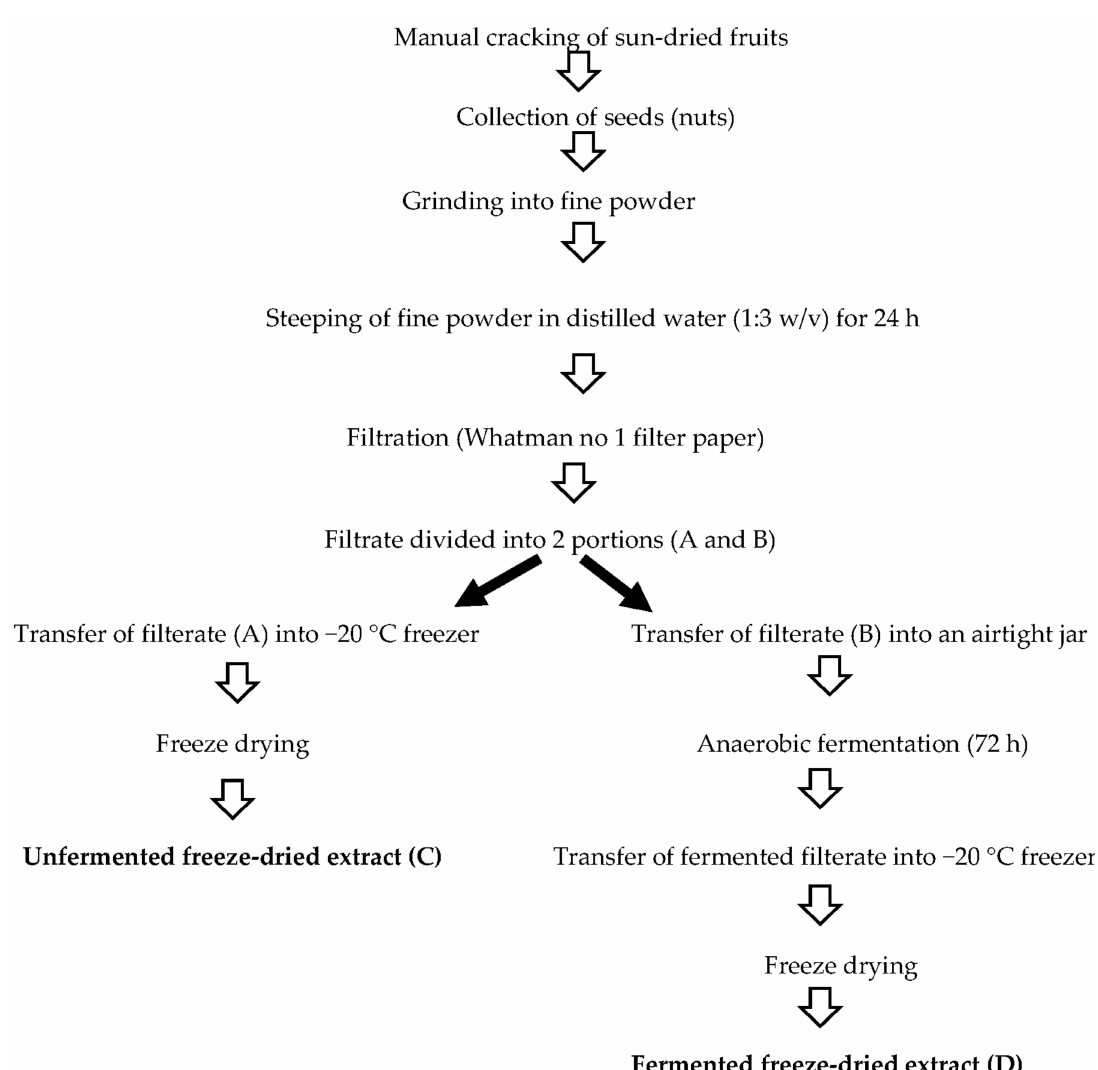
Figure 3. Flow chart illustrating the preparation of flour, unfermented and fermented freeze-dried extracts from T. catappa